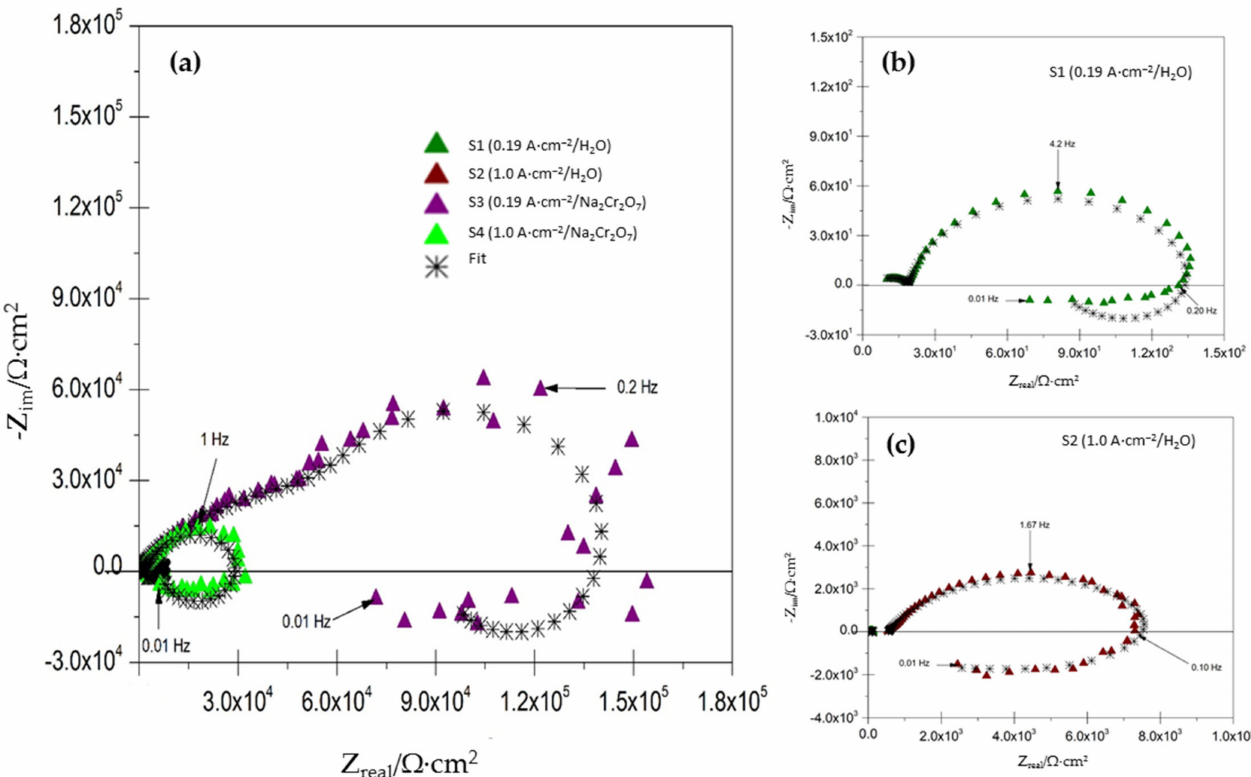
Figure 3. Nyquist diagrams of anodized AA2055 samples immersed to 10 vol.% H 2 SO 4 : ( a ) S1–S4, ( b ) S1 and ( c )